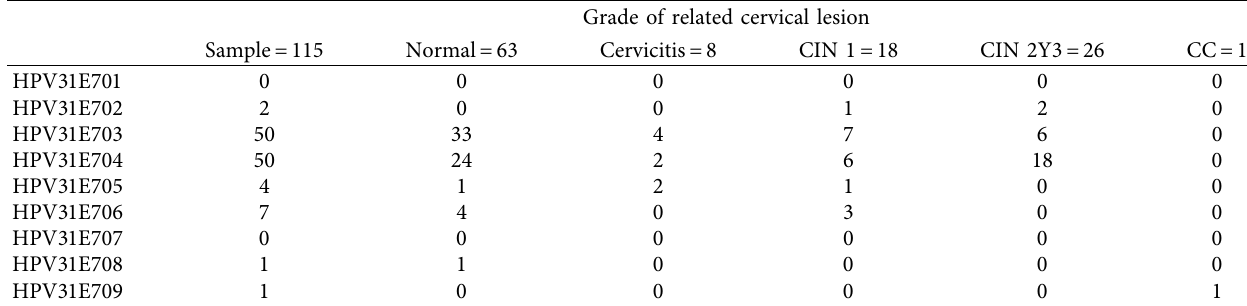
Table 7: Te associations of HPV31E7 variants with cervical disease.